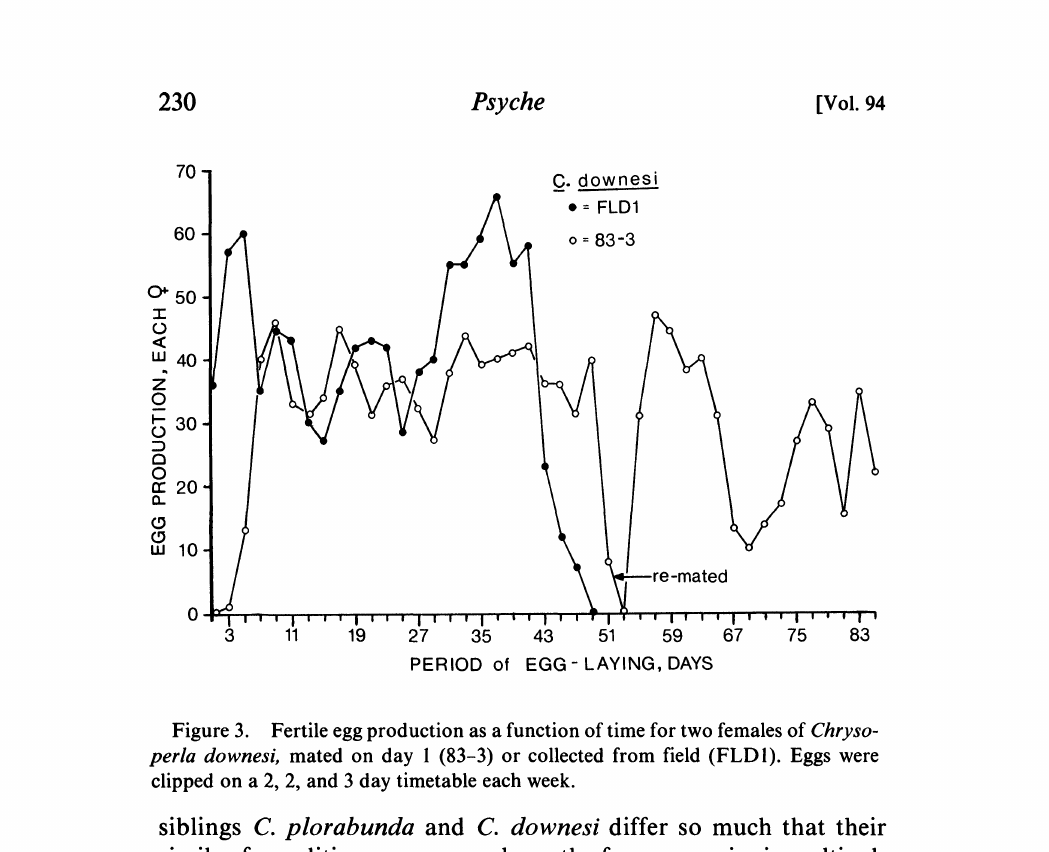
Figure 3. Fertile egg production as a function of time for two females of Chryso- perla downesL mated on day (83-3) or collected from field (FLD1). Eggs were clipped on a 2, 2, and 3 day timetable each